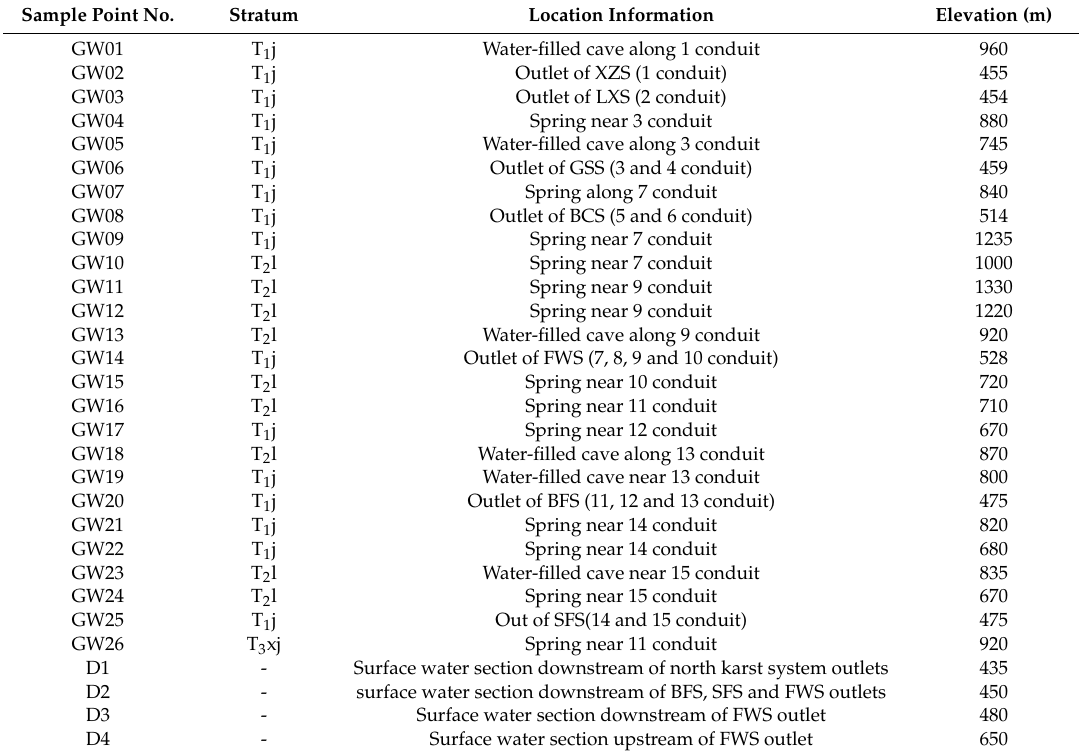
Table 1. Sampling point basic information.